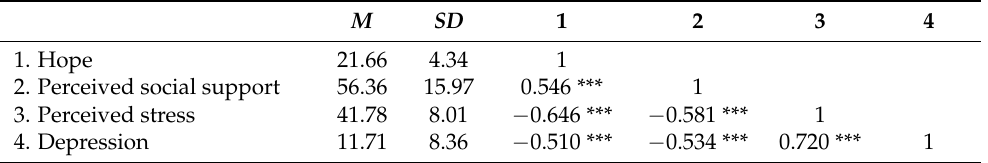
Table 2. Means, standard deviations and correlation coefficients for key